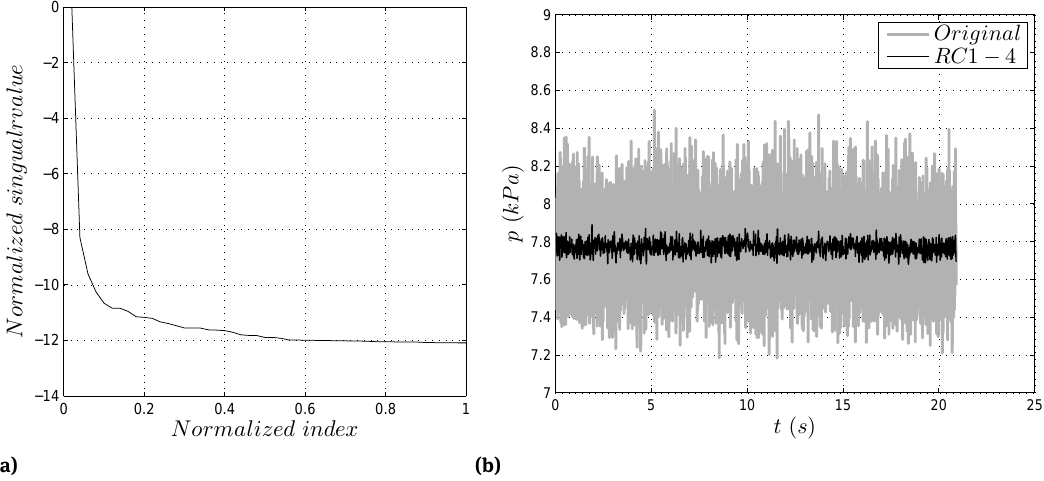
Figure 7: a) Singular value spectra and b) Source signal and sum of its three first principal components at inlet recirculation (TOA = 20%) at the blower